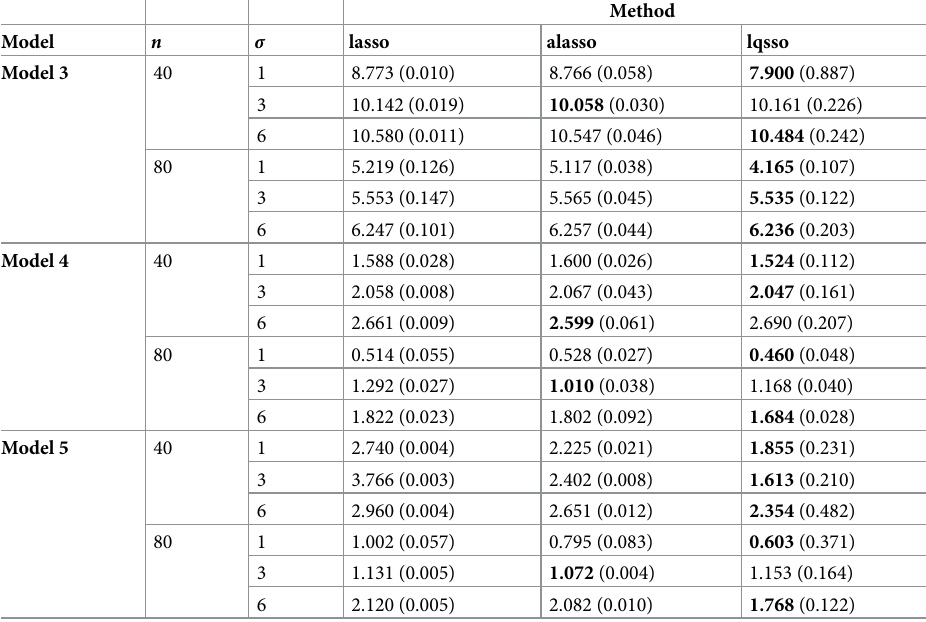
Table 4. The mean values of bias for Model 3, Model 4 and Model 5.